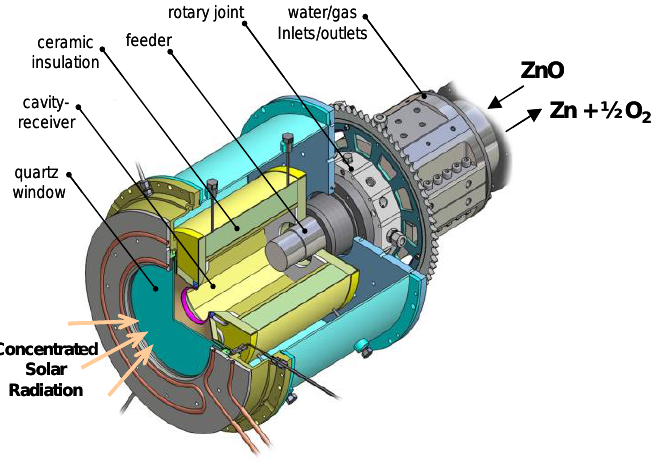
Figure 3. Schematic of the solar rotary reactor configuration